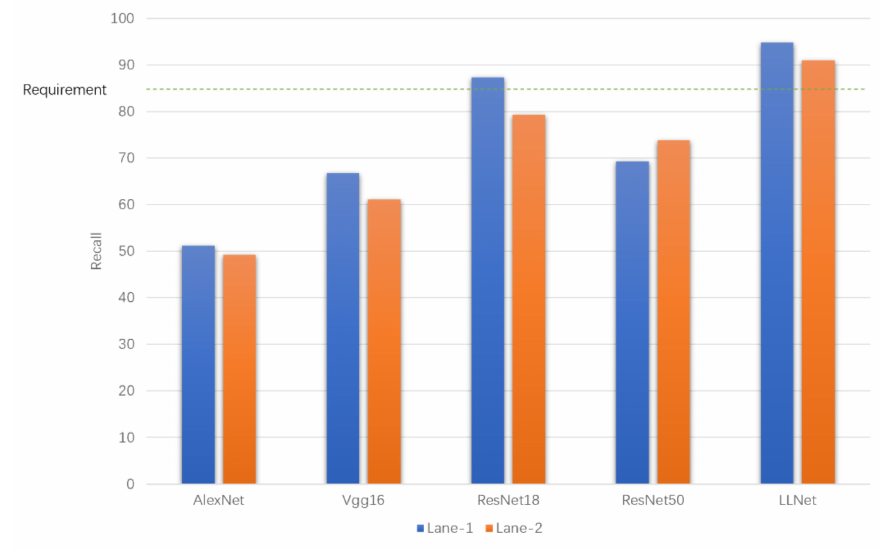
Figure 11. The requirement for recall and performance of the baselines and